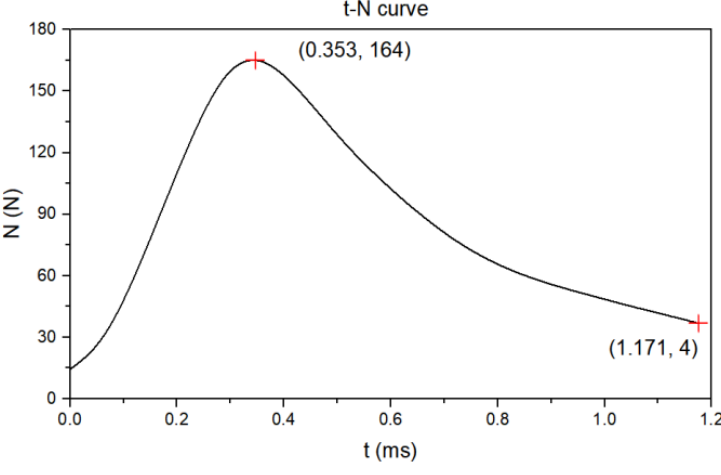
Figure 6. Value of N.